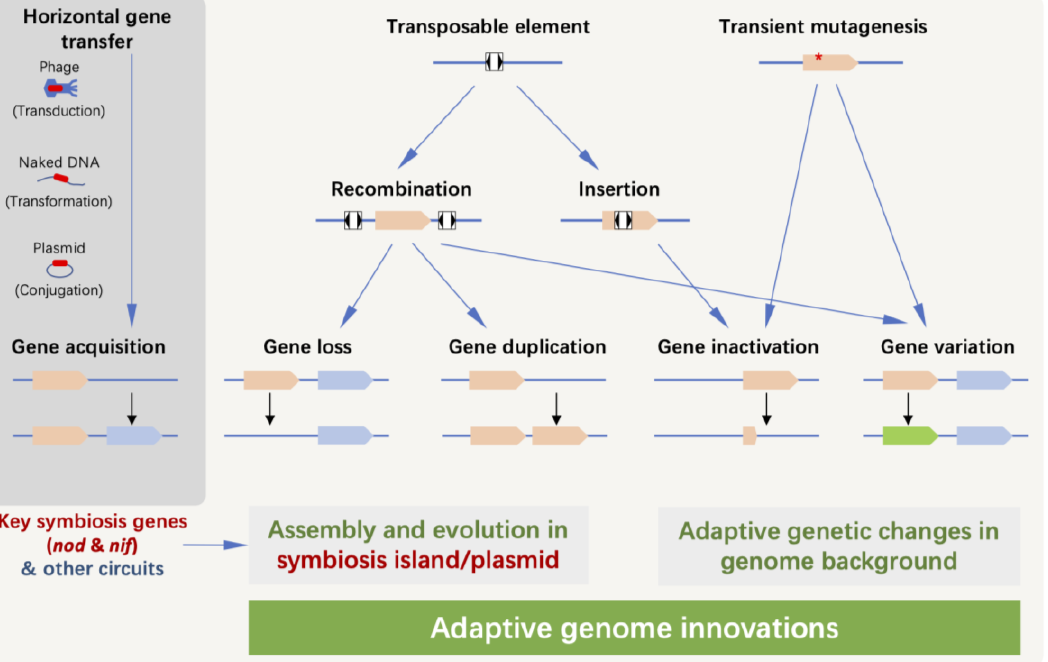
Figure 2. Genome innovations after receiving key symbiosis genes. The main patterns of rhizobial genome innovation in adaptive evolution include gene acquisition, loss, duplication, inactivation and variation, mediated by transposable elements and transient hyper-mutagenesis. Red star indicates a point mutation.